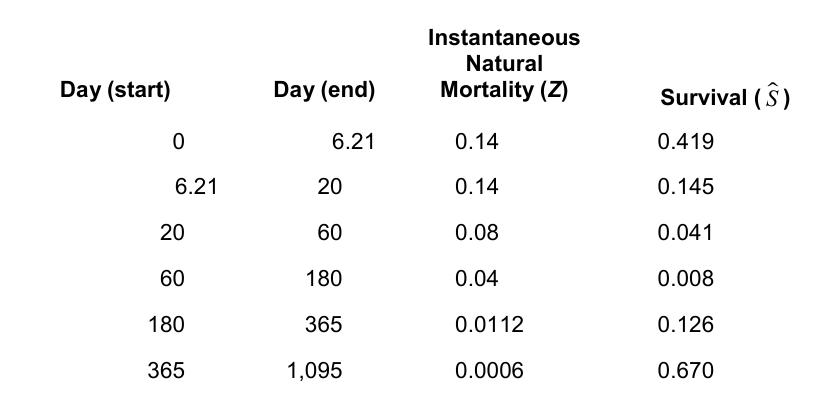
3-Year Survival for the KGB Rockfish Complex Based on Blue Rockfish